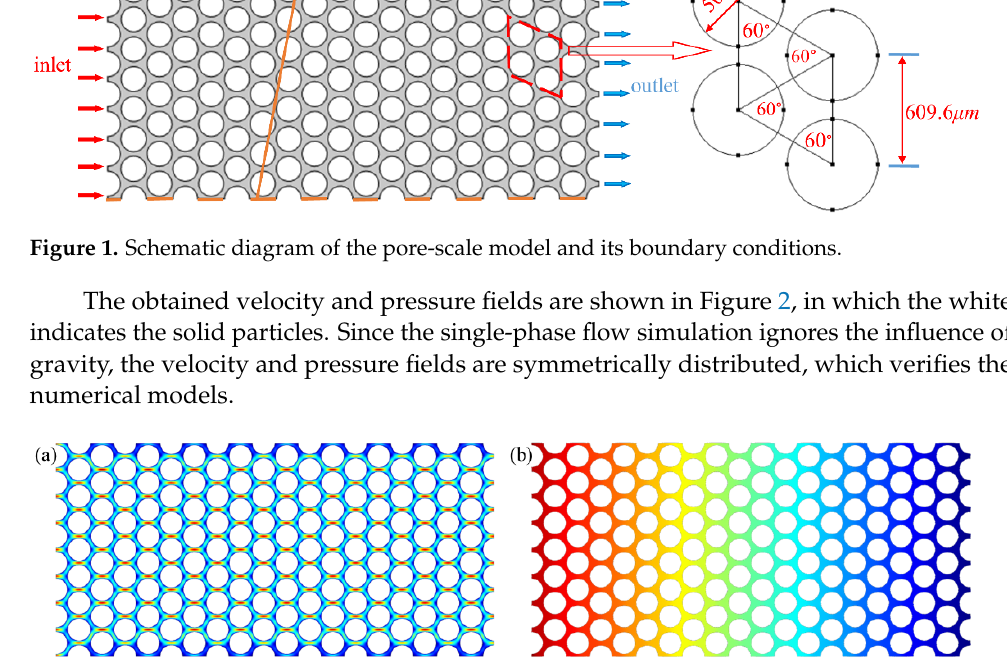
Figure 2. Simulation results of single ‐ phase flow. ( a ) Velocity distribution; ( b ) Pressure distribution.